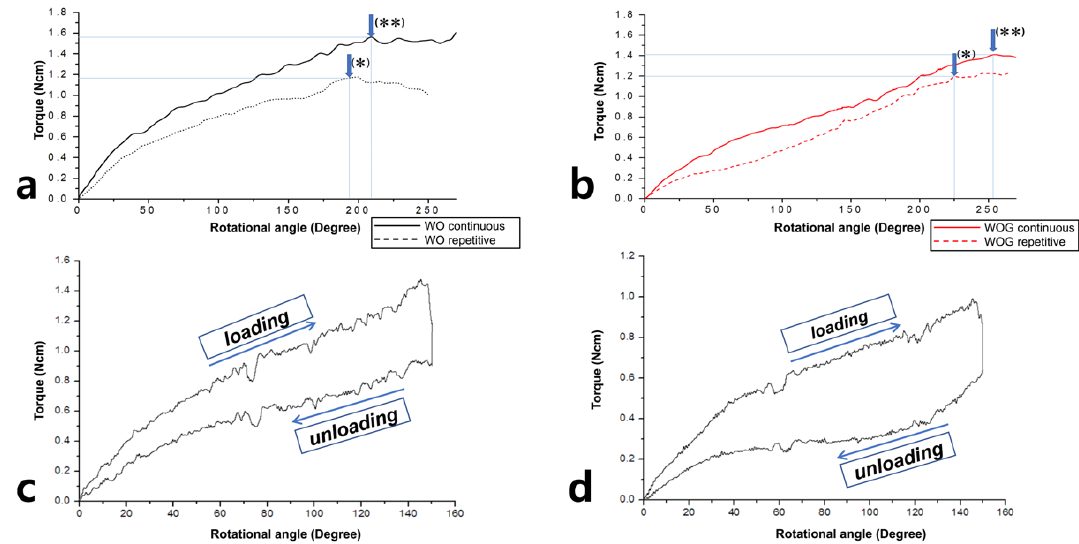
Figure 2. Representative superimposed plot acquired from the repetitive ( dotted line ) and single continuous rotation ( solid line ) torsional test for ( a ) WO and ( b ) WOG. Arrows indicate the TLP from the ( a ) repetitive and ( b ) continuous rotation torsional test. A typical strip chart for ( c ) WO and ( d ) WOG showed that single continuous rotation to 150-degree and returning to original position result in superelastic response.